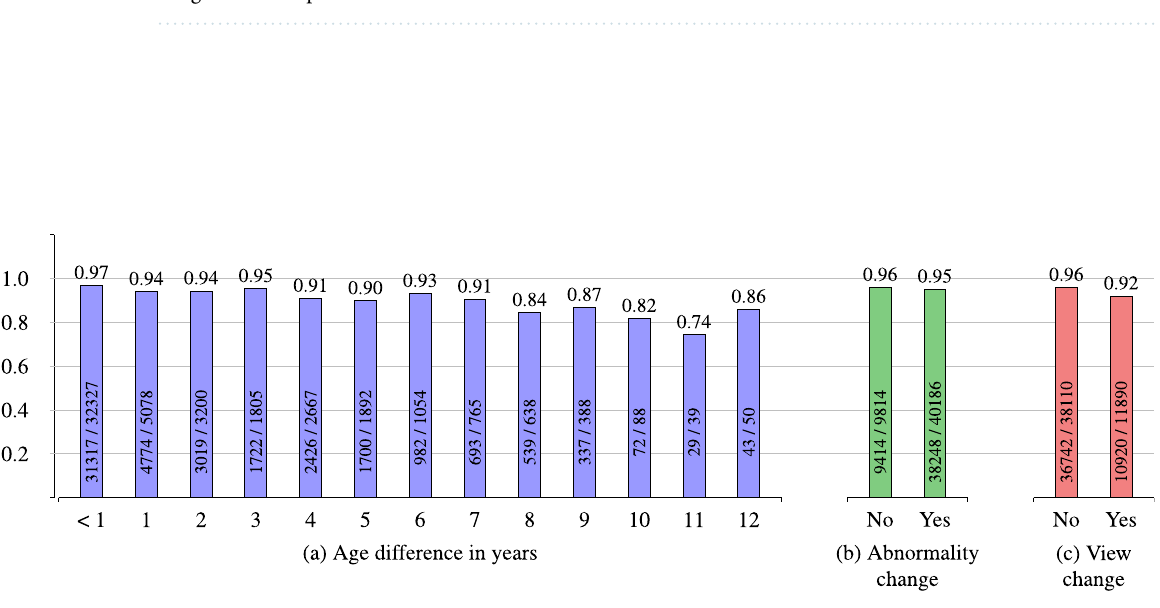
Figure 3. Confusion matrix corresponding to the best experiment shown in Table 1 (last row) giving clear insights into the performance of our trained model.